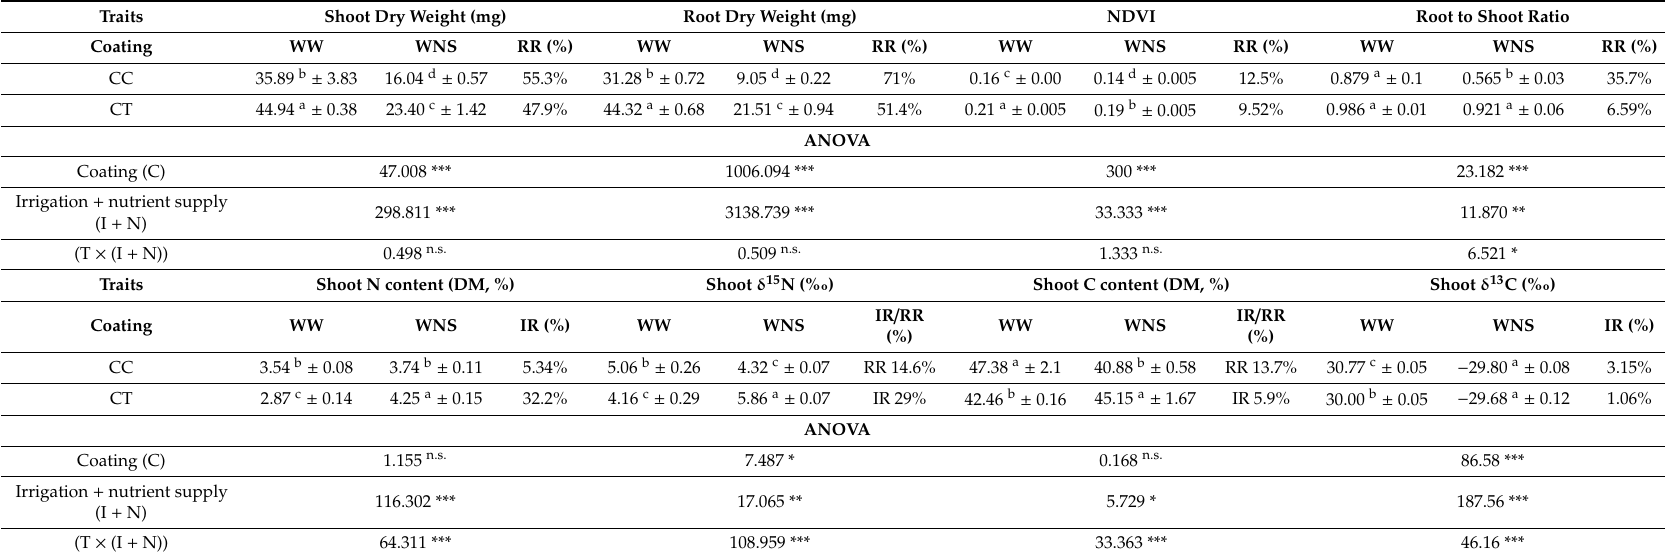
The F values are shown, and the symbols indicate statistical significance ( n.s. p > 0.1, * p < 0.05; ** p < 0.01; *** p < 0.001). Values with di ff erent superscript letters are significantly di ff erent classes according to the LSD test ( p ≤ 0.05). DM: Dry matter; WW: Well watered; WNS: Water / nutrient stress; RR: Reduction rate; IR: Increase rate; CC: Coated control; CT: Coated with thyme